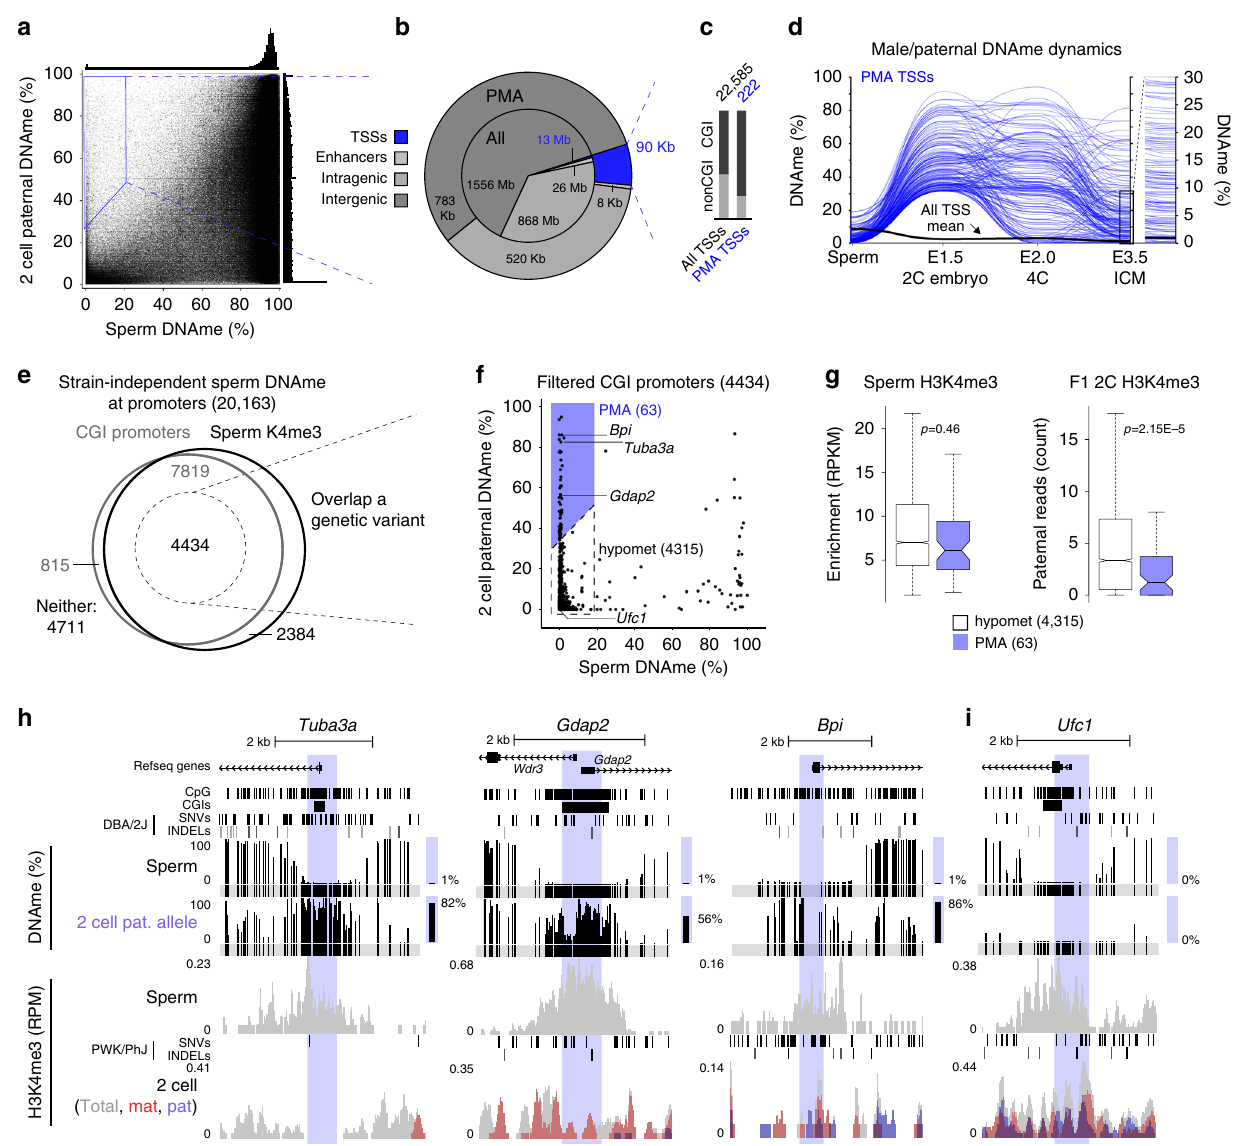
Fig. 1 Paternal DNA methylation acquisition (PMA) at CpG-rich promoters by the 2C stage. a Male/paternal DNAme levels in sperm and 2C F1 hybrid embryos. Each data point represents the mean DNAme level over a 600 bp genomic bin overlapping at least two informative CpGs (covered by 5× reads and separated by >1 sequencing read length) in both datasets ( n = 3,611,409). Bins showing PMA ( ≥ 30% gain in paternal DNAme) are highlighted. Histograms depicting the distribution of DNAme levels in both datasets are included. b Pie chart illustrating the genomic lengths of TSSs, enhancers, gene bodies (intragenic) and intergenic loci: genome-wide (inner circle) and over regions that show PMA (outer circle). c The proportion of CpG island promoters in annotated autosomal TSSs versus those that undergo PMA, with the number of TSSs shown above. d Parallel-coordinate plot illustrating male/paternal DNAme dynamics over TSSs that undergo PMA in sperm and the preimplantation embryo. Each line represents a TSS that undergoes PMA and overlaps at least two informative CpGs in each dataset ( n = 175). The mean DNAme level of autosomal TSSs is indicated by a black line. DNAme levels for E3.5 (ICM) are shown on two scales to illustrate the retention of DNAme at this stage. e Venn diagram including all annotated autosomal promoters with sperm DNAme levels consistent between C57BL/6J and DBA/2J strains. The proportion of such promoters with high/intermediate CpG density (CGIs) and enriched for H3K4me3 in sperm is depicted. The subset overlapping a genetic variant and at least two informative CpGs in sperm and 2C WGBS datasets are indicated. f CGI promoters showing PMA ( ≥ 30% gain in paternal DNAme) from sperm to the 2C stage ( n = 63) versus persistent hypomethylation (hypomet, n = 4315) are shown. g Distribution of H3K4me3 levels at PMA ( n = 63) or hypomet ( n = 4315) CGI promoters is shown for sperm (left) and on the paternal allele in 2C embryos (right). Boxplots show the median (line inside the box), where 50% of the data are distributed (the box), and whiskers denote the values lying within 1.5 times the interquartile range. Two-sided t-tests assuming unequal variances were performed. h , i UCSC genome browser screenshots of the promoter regions of Tuba3a , Gdap2 , Bpi and Ufc1 . TSS regions ( + / − 300 bp) are highlighted in blue and the location of informative CpGs (5× coverage) for each WGBS dataset are highlighted in grey below each WGBS dataset. Mean DNAme levels over- highlighted regions are indicated to the right of each DNAme genomic track. The genomic locations for NCBI Refseq genes, all CpG dinucleotides, CGIs and genetic variants used in our allele-speci fi c analyses (SNVs and INDELs) are also included. 2C H3K4me3 data are represented as a composite track containing total (allele-agnostic, grey), maternal (red) and paternal (blue) genomic tracks. Source data are provided as Source Data and Supplementary Data 3 fi